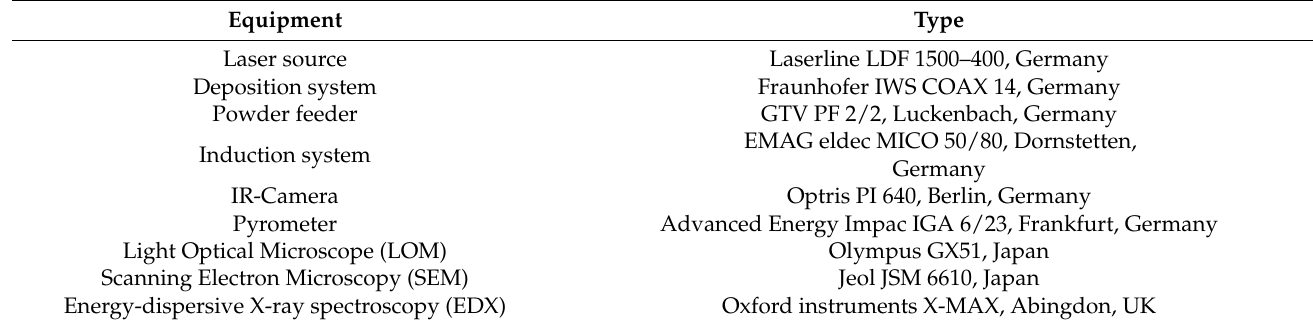
Figure 2. Test set up for the conducted LMD trials. Table 2. Equipment used for the presented experimental